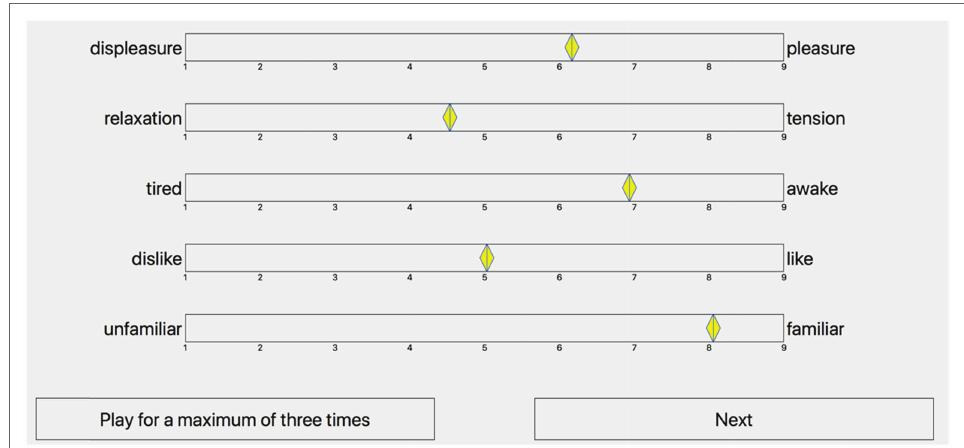
FIGURE 1 | The interface for the listening